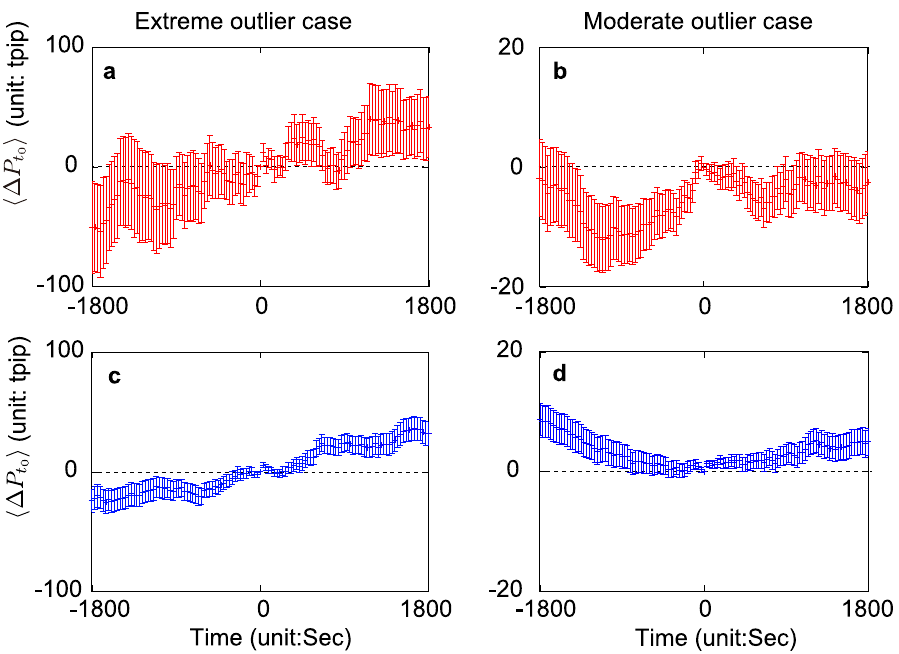
Fig 9. Average price changes around the end (top panels (a,b)) and the beginning (bottom panels (c,d)) of outlier trades. The ordinate represents the average price changes at the end (a,b) and the beginning (c,d) of outlier trades, and the abscissa covers three minutes before and after the end (a,b) and the beginning (c,d) of outlier trades, which corresponds to time 0. We used extreme outliers to make Fig (a,c) with sample size of 12 (a) and 102 (c), and moderate outliers to make Fig (b,d) with sample size of 405 (b) and 1827 (d). Error bars represent the standard errors. Note that the ordinate of the extreme outlier case is five times larger than that of the moderate outlier case. These graphs imply the following two points. First, MMs keep jacking up limit-order prices even after the end of the extreme outlier trades (a), whereas they do not behave in this manner after the end of the moderate outlier trades (b). Second, banks prefer to follow (c) (go against (d)) market-price trends when handling extreme (moderate) outlier